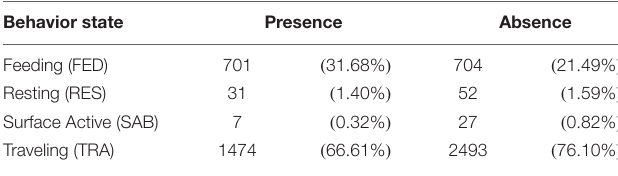
TABLE 8 | Number of observations of whales in Juneau waters according to behavior states for presence (with whale watching vessels) and absence (without whale watching vessels)